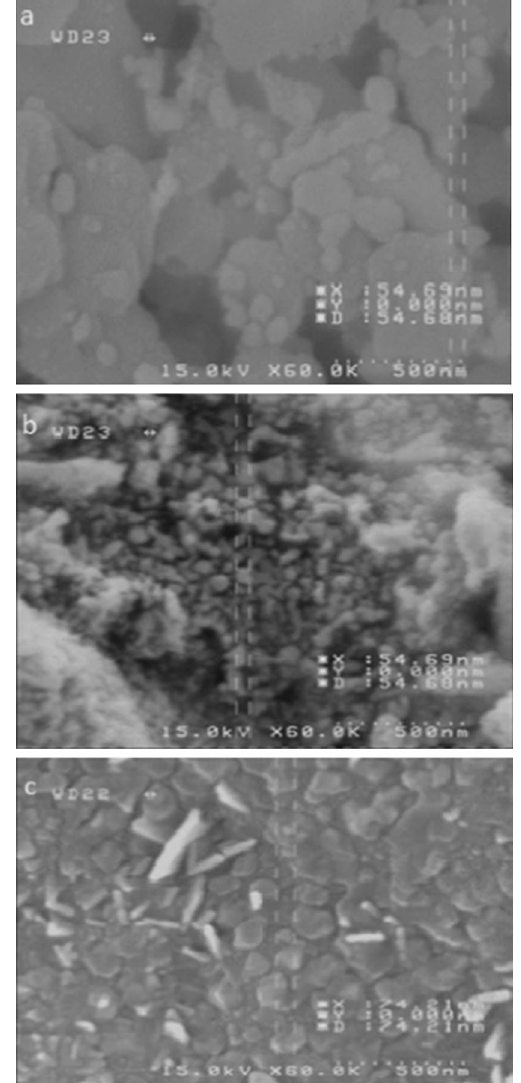
Fig. 3 Scanning electron micrograph image from samples a, b and c